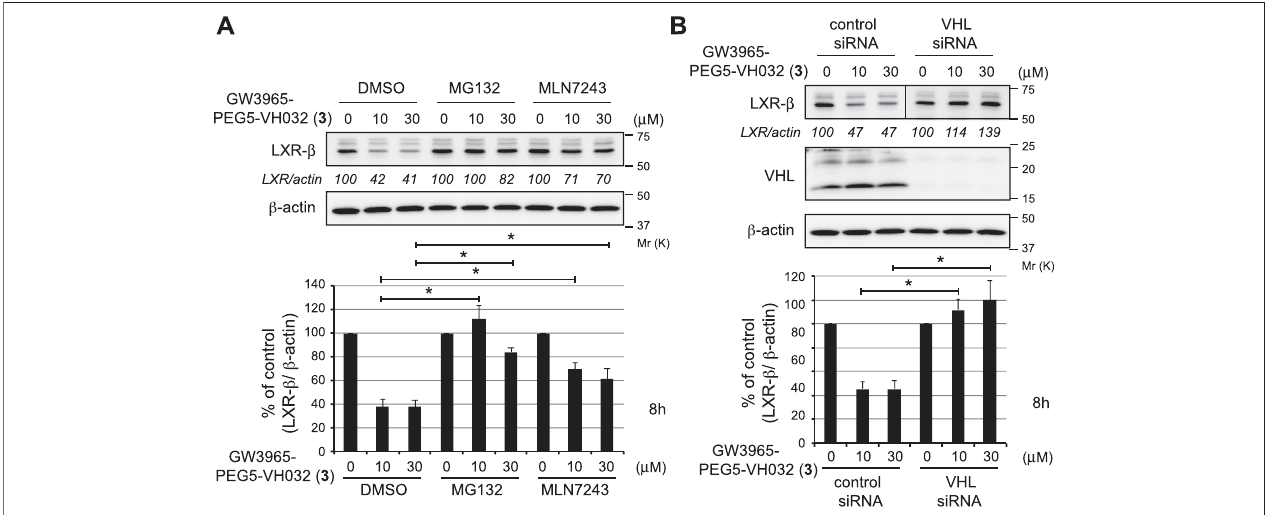
FIGURE 3 | Mechanism of LXR β reduction by GW3965-PEG5-VH032 ( 3 ). (A) Effect of UPS inhibitors on GW3965-PEG5-VH032-induced reduction of the LXR β protein. HuH-7 cells that had been cultured in DMEM containing 10% FBS were treated with the indicated concentrations of GW3965-PEG5-VH032 in the presence or absence of 10 μ m of MG132 or MLN7243 for 8 h (B) VHL E3 ligase is required for the degradation of the LXR β protein by GW3965-PEG5-VH032. HuH-7 cells were transfectedwiththeVHLsiRNAfor42 handtreatedwiththeindicatedconcentrationsofGW3965-PEG5-VH032for8 h.AmixtureofthreedifferentsiRNAsagainst VHL was used to suppress expression. Immunoblots of cell lysates that had been stained with the indicated antibodies are shown (representative data are shown). The numbersbelowtheLXR β panelsrepresentLXR/actinnormalized bydesignatingtheexpressionfromthevehiclecontrolconditionas100%.Datainthebargrapharethe mean ± S.D. (error bars) of three independent experiments. Asterisks indicate p < 0.05.